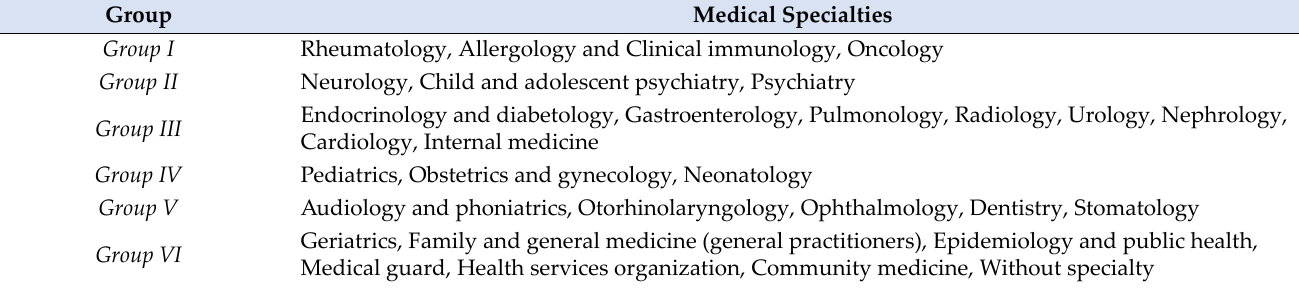
Table 1. Group of medical specialties clustered by affinity. Group I: Immunological and oncological specialties; Group II: Neuro‑psychiatric specialties; Group III: Internal and radiological specialties; Group IV: Gynecological and pediatric specialties; Group V: Sensory organs specialties; Group VI: Public and family specialties; Group VII: